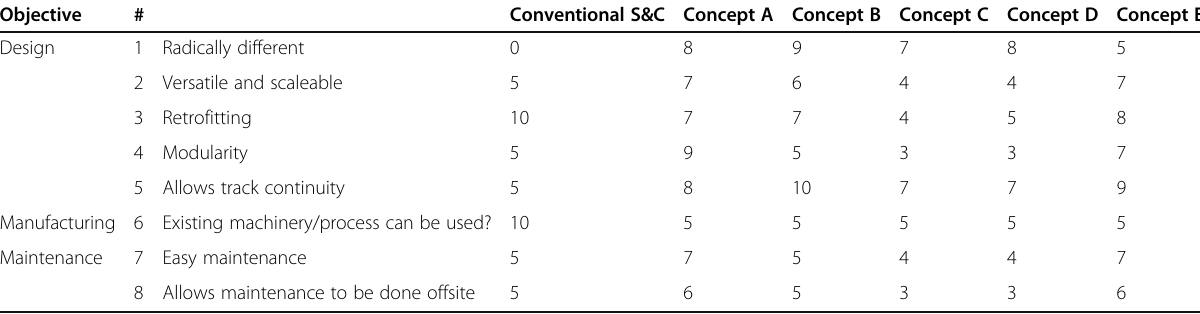
Table 3 An extract from Pugh matrix showing selected concepts and criteria